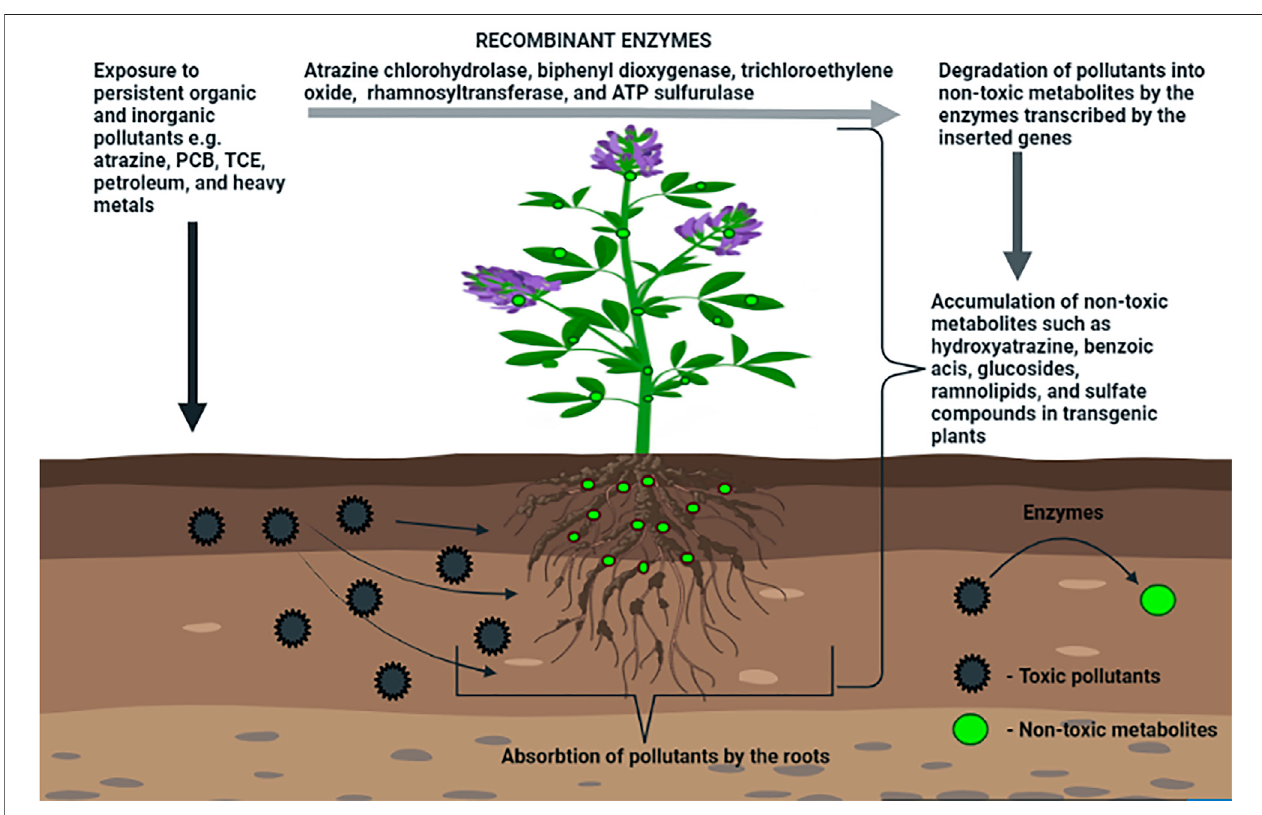
FIGURE 1 | Schematic representation of phytoremediation strategies by transgenic alfalfa plants. Phytoremediation processes by transgenic plants include phytoaccumulation (plants take up persistent organic and inorganic pollutants with soil water and store the contaminants in their tissues) and phytodegradation (metabolism of contaminants within plants due to expression of transgenes). The phytotoxic effects of atrazine, polychlorinated biphenyl (PCB), and petroleum are overcomebyexpressingthebacterialgenes AtzA,bphC,B, and rhlA. Expressionofmammaliangenes CYP2E1 and GST enhancedegradationoftrichloroethylene (TCE). Overexpression of plant gene ATPS improves heavy metal tolerance. Degradation of pollutants into non-toxic metabolites occurs by the enzymes transcribed by the inserted